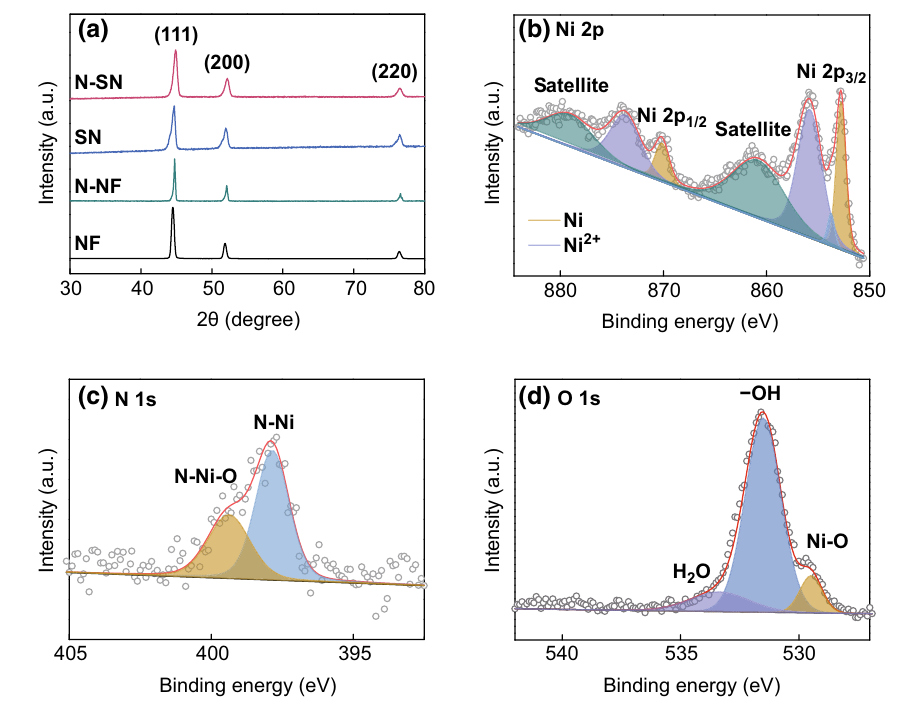
Fig. 3 a XRD patterns of NF, N-NF, SN, and N-SN. XPS spectra of initial N-SN before cycling: b Ni 2p, c N 1s, d O